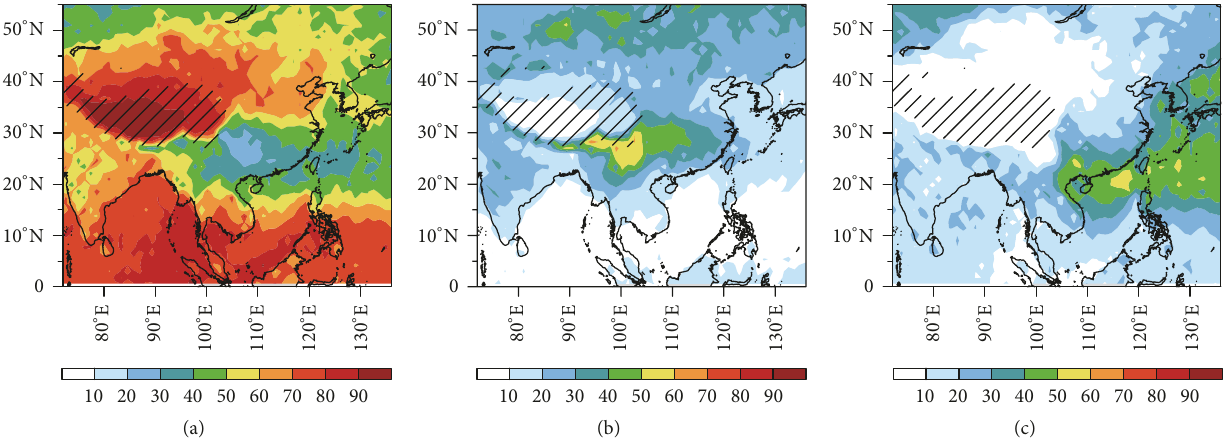
Figure 4: Horizontal distribution of the occurrence of single-layer (a) high, (b) middle, and (c) low cloud over China and surrounding areas (unit: %). The shaded part indicates that the surface elevation is above 3.1 km (680